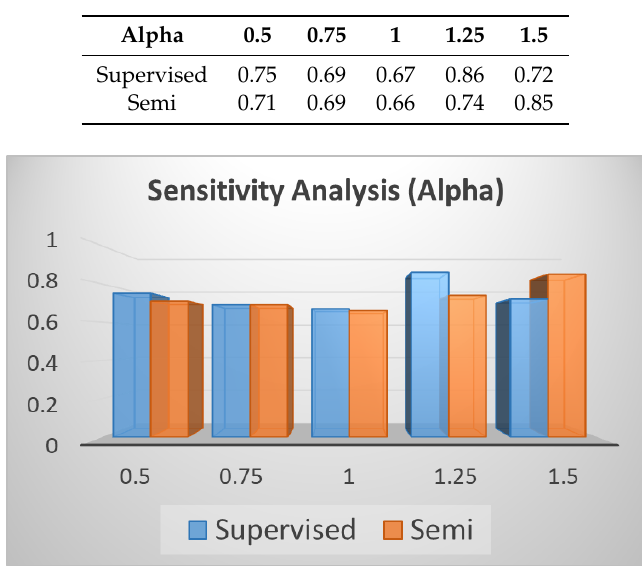
Figure 9. Sensitivity Analysis